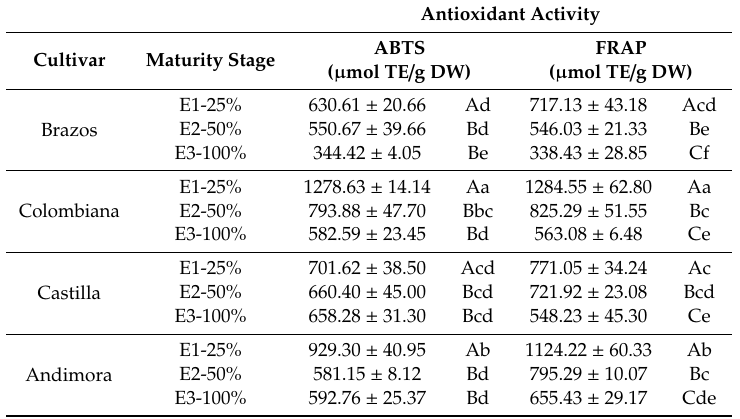
Table 4. Antioxidant activity of four blackberry cultivars from